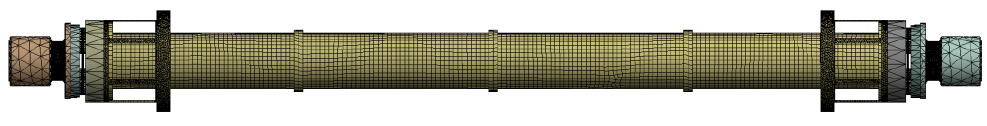
Figure 4. Meshed Figure 4. Meshed geometry. Figure 4. Meshed geometry.